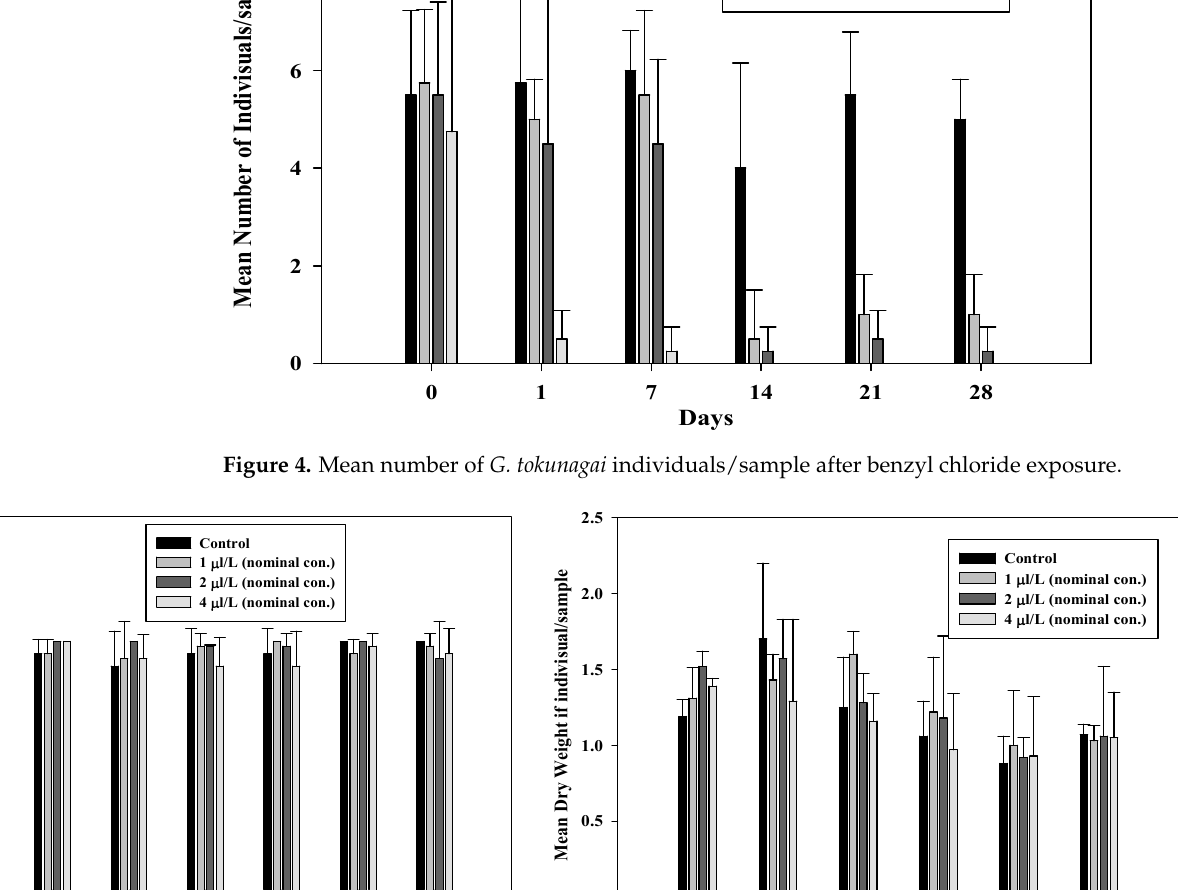
Figure 5. ( a ) Mean number and ( b ) dry weight of L. hoffmeisteri individuals/sample after benzyl chloride exposure.